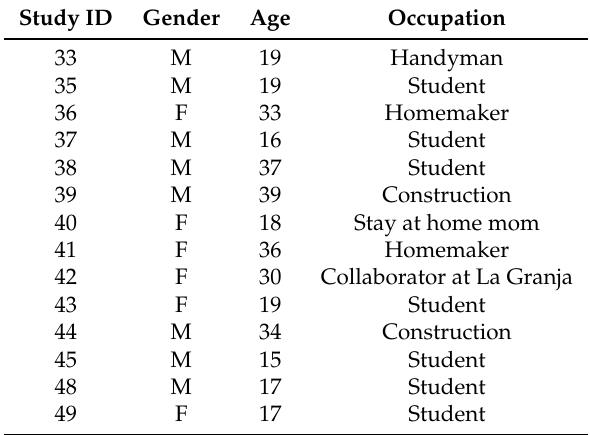
Table 1. Participants in the